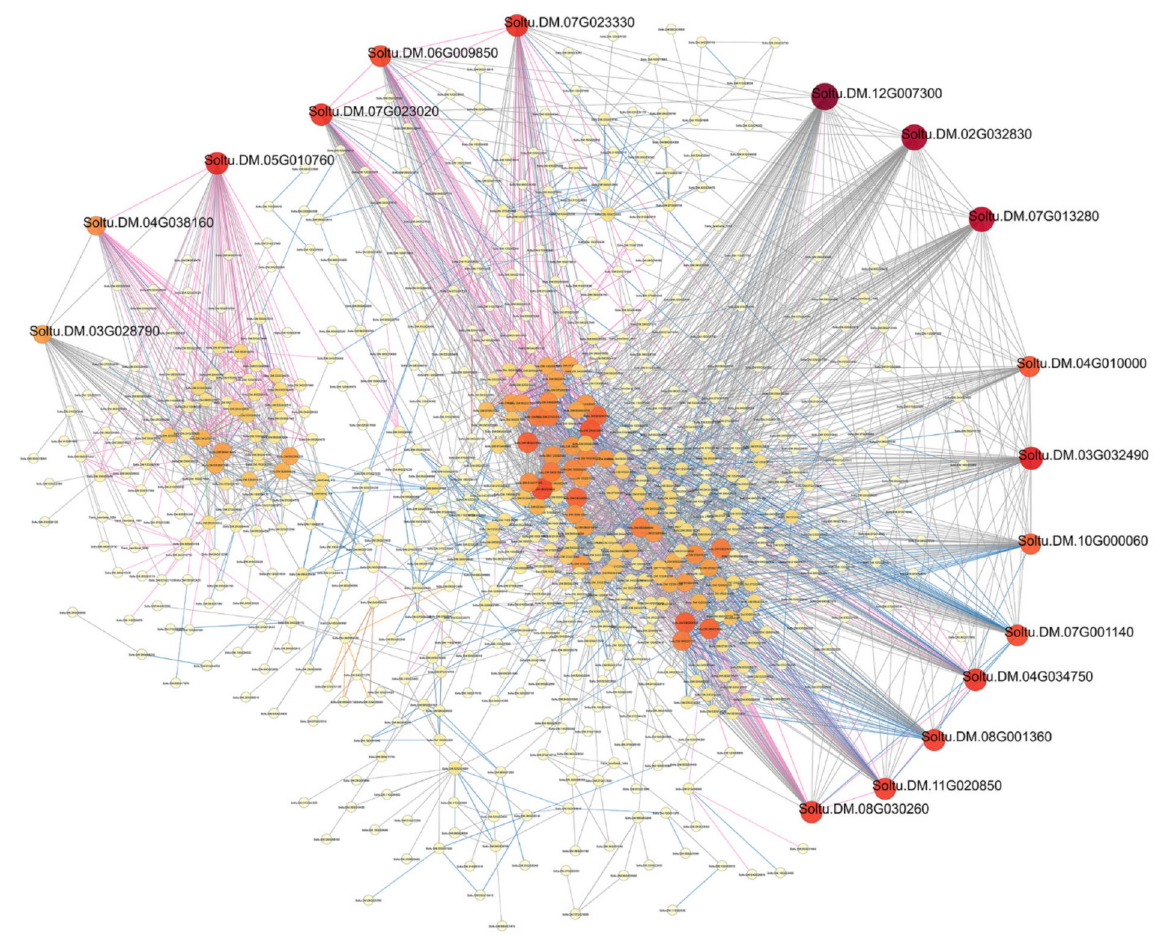
Figure 8. A PPI network of DEGs from variety A versus Q under dual treatment for 6 h. The interac- tion relationship in the STRING protein interaction database (http://string-db.org/ 6 September 2021) was then used to analyze DEG coding protein interaction network. The ID of key hubs corresponding proteins were as follows: Soltu.DM.12G007300: ATP synthase delta chain; Soltu.DM.02G032830: